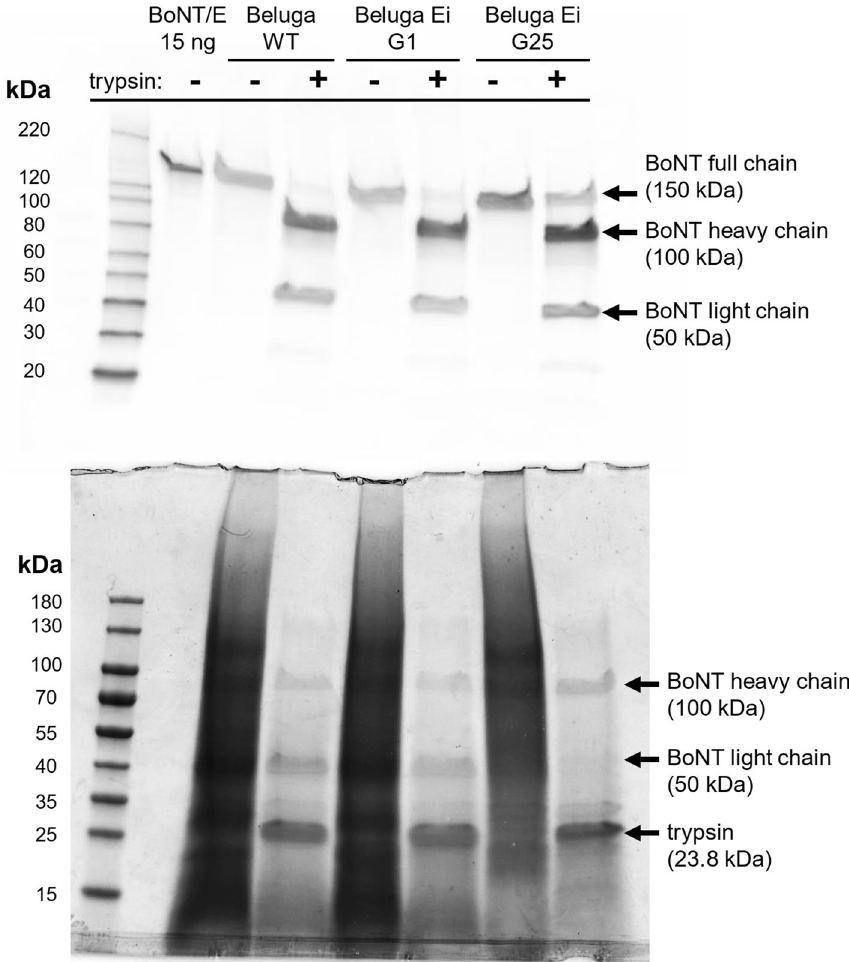
Figure 4. Botulinum neurotoxin (BoNT) type E-directed Western blot (upper picture) and the representative Coomassie-stained polyacrylamide gel (lower picture) validating the correct trypsin-cleavage of BoNT/E and BoNT/Ei produced by 1st and 25th generations of the Clostridium botulinum Beluga Ei strain (Beluga Ei G1 and Beluga Ei G25). Samples were diluted in standard phosphate-gelatin buffer prior to addition of trypsin. In the absence of trypsin gelatin creates strong background visible in Coomassie-stained gel. Full-length images of the Western blot membrane and of the Coomassie-stained gel are presented in Supplementary Figures S4 and S5,